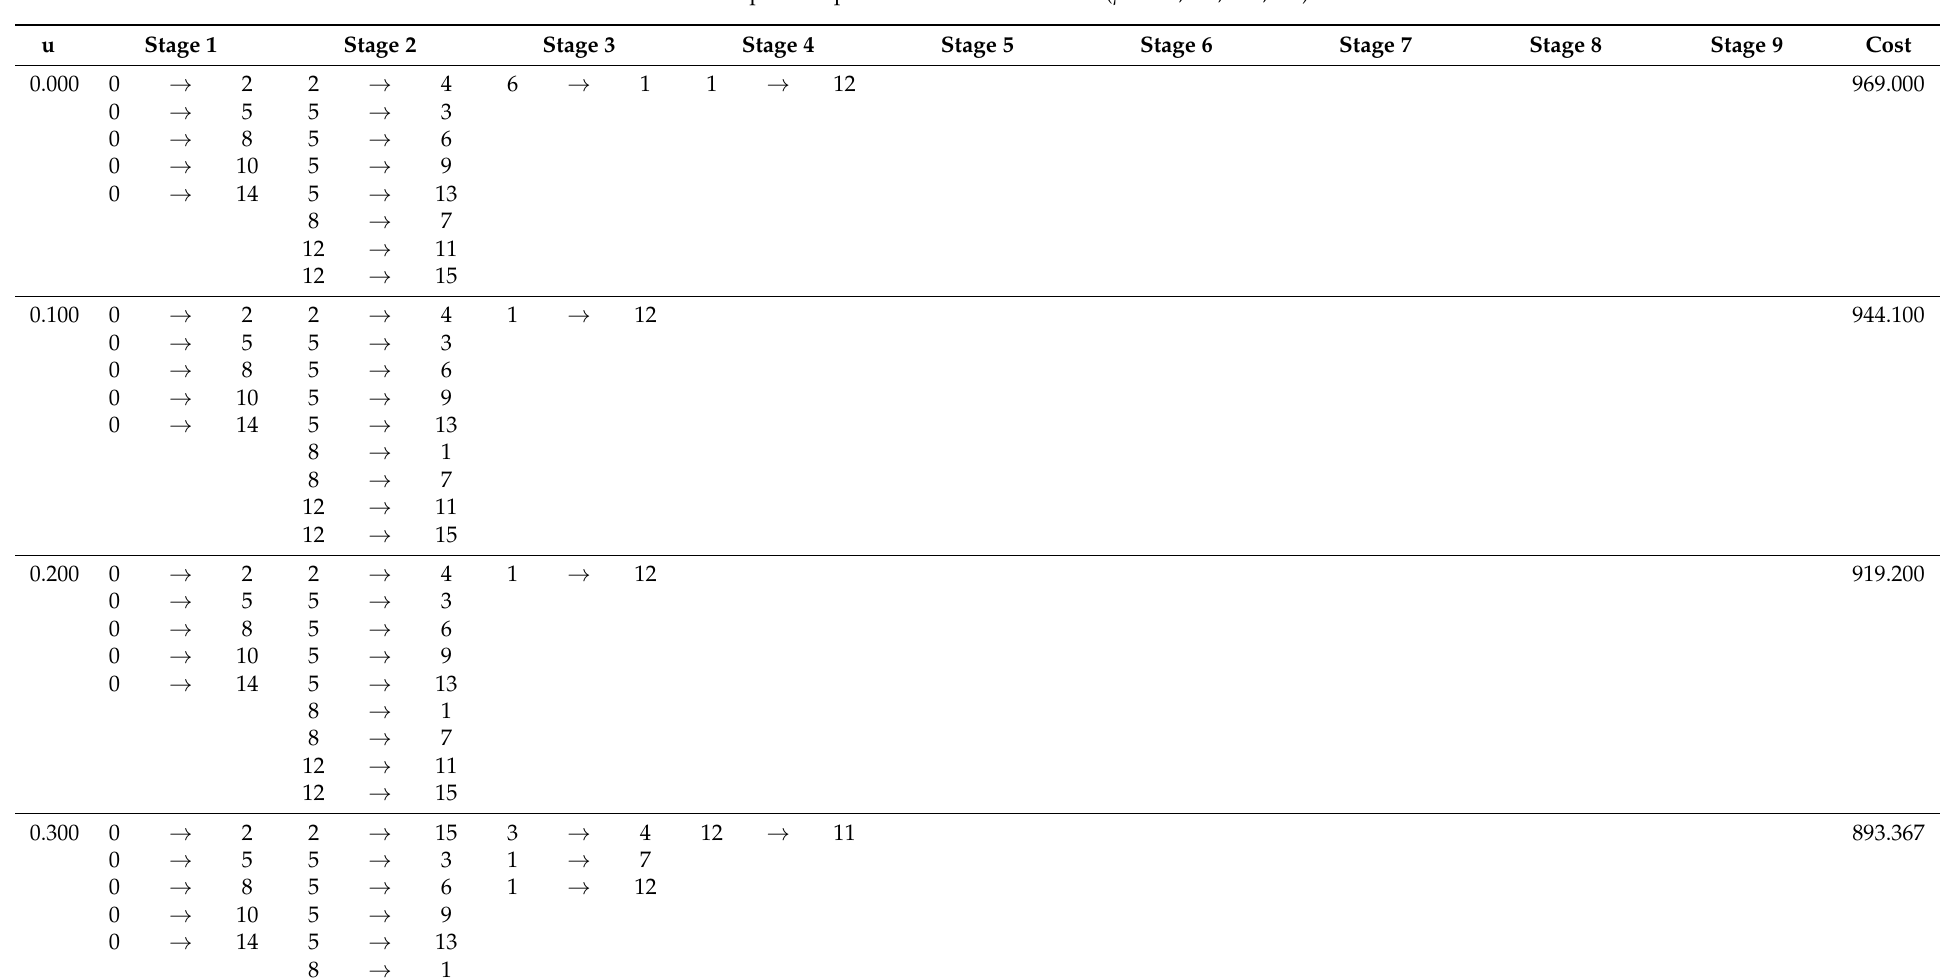
Table 4. Expansion process and costs of firm X ( µ = 0.0, 0.1, . . . ,